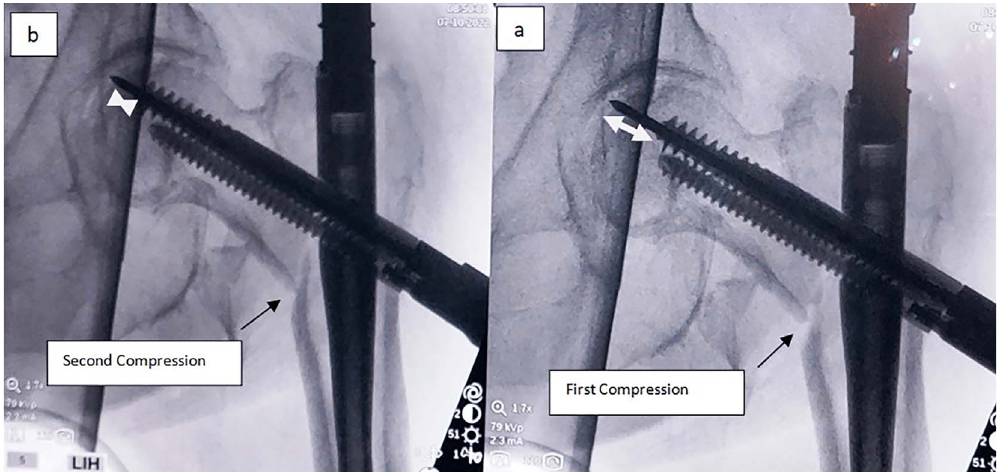
Figure 4. Suf fi cient space under the subchondral region is evident (a), which offers us the ability to advance further the lag screw (b), in order to proceed to the second compression and maximum reduction of the gap (arrow).